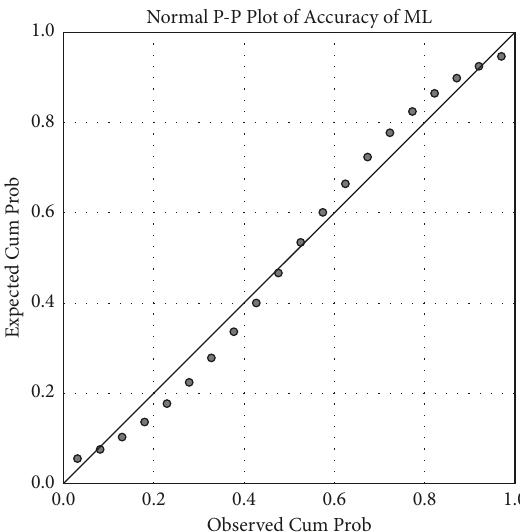
Figure 5: P–P plot of ML accuracy.